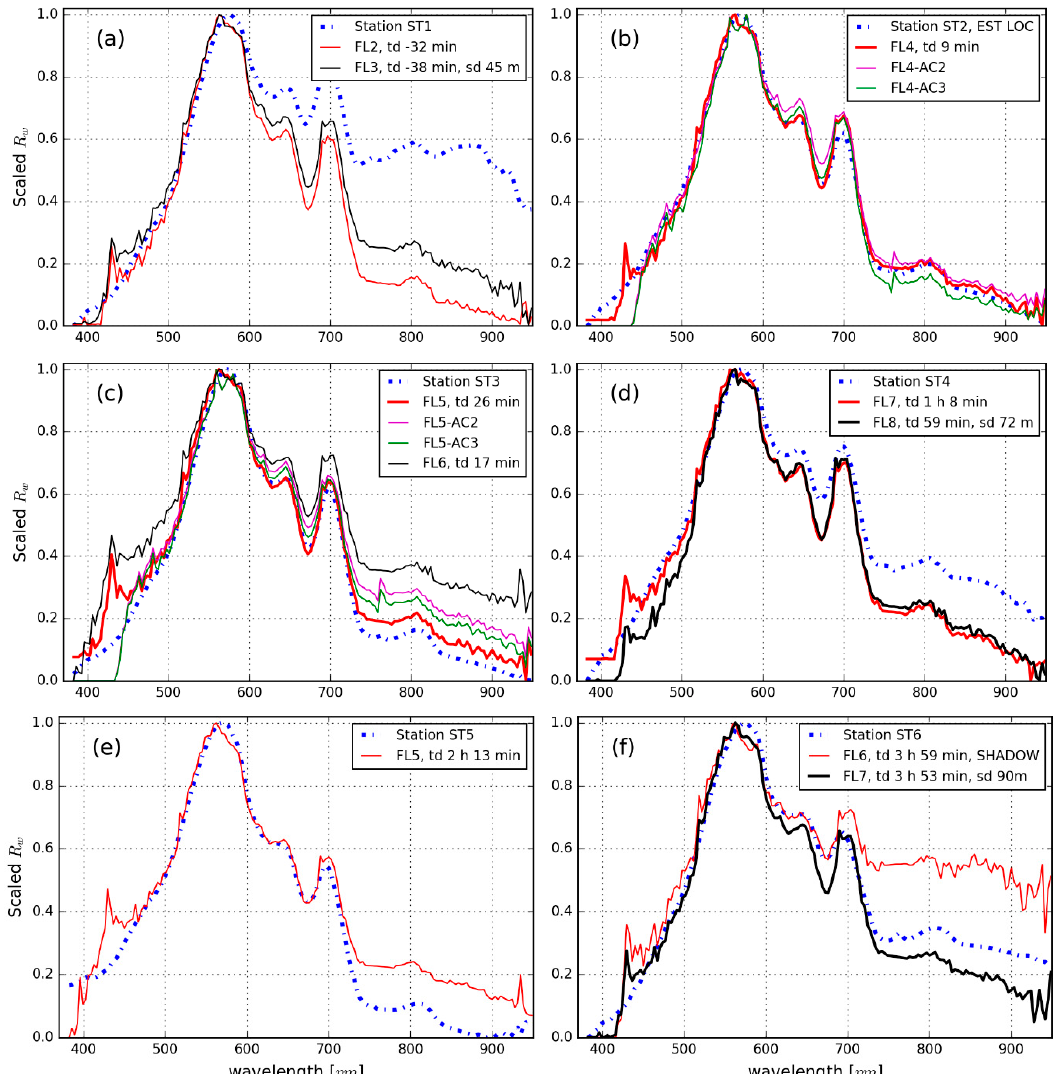
Figure 6. ( a – f ) In situ station and image-derived R w spectra standardized between 0 and 1. Image spectra corresponding to the best five comparisons are plotted as thicker lines. Image-derived standardized R w from atmospheric correction strategies AC2 and AC3 are included in panels ( b , c ). In panel legends, td = time difference between in situ measurement and image acquisition, and sd = distance between in situ and image measurement.